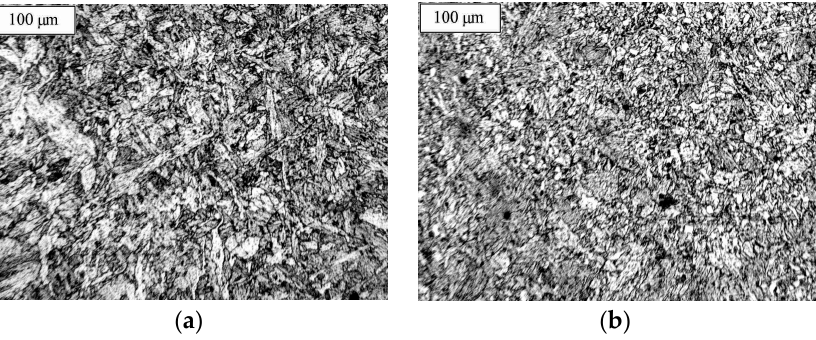
Figure 1. Microstructure of G17CrM05-5: ( a ) non-modified cast steel; ( b ) cast steel with REMs, LM, etched with HNO 3 solution in C 2 H 5 OH.